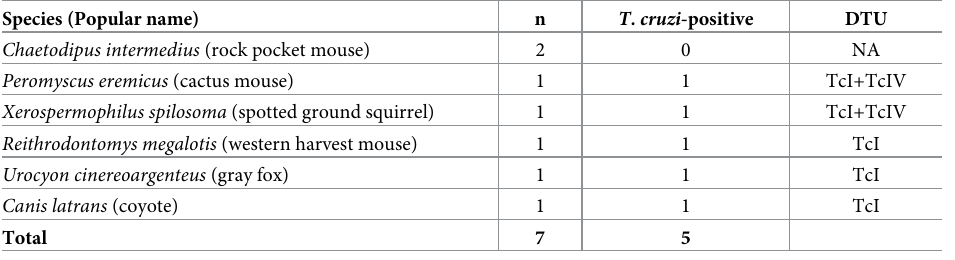
Table 4. Prevalence of T . cruzi infection and DTU genotyping in wild animals collected at Hitt Canyon, El Paso County,